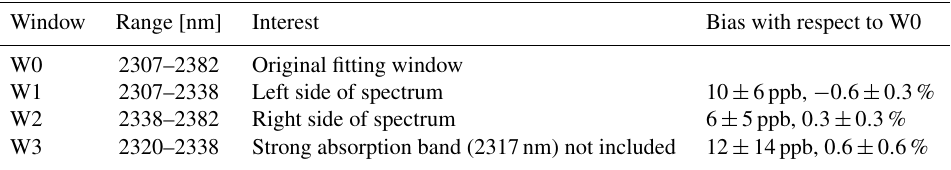
Table 4. Spectral fitting windows used in the non-scattering XCH 4 retrieval for the upper-edge ensemble and the bias and standard deviation of the differences in the retrieved XCH 4 with respect to the original fitting window